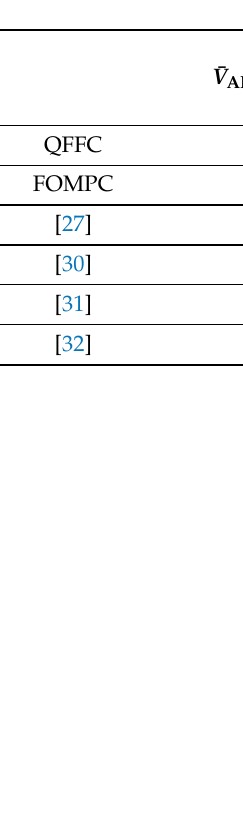
Table 2. The summary of our results and the comparison with those in the previous